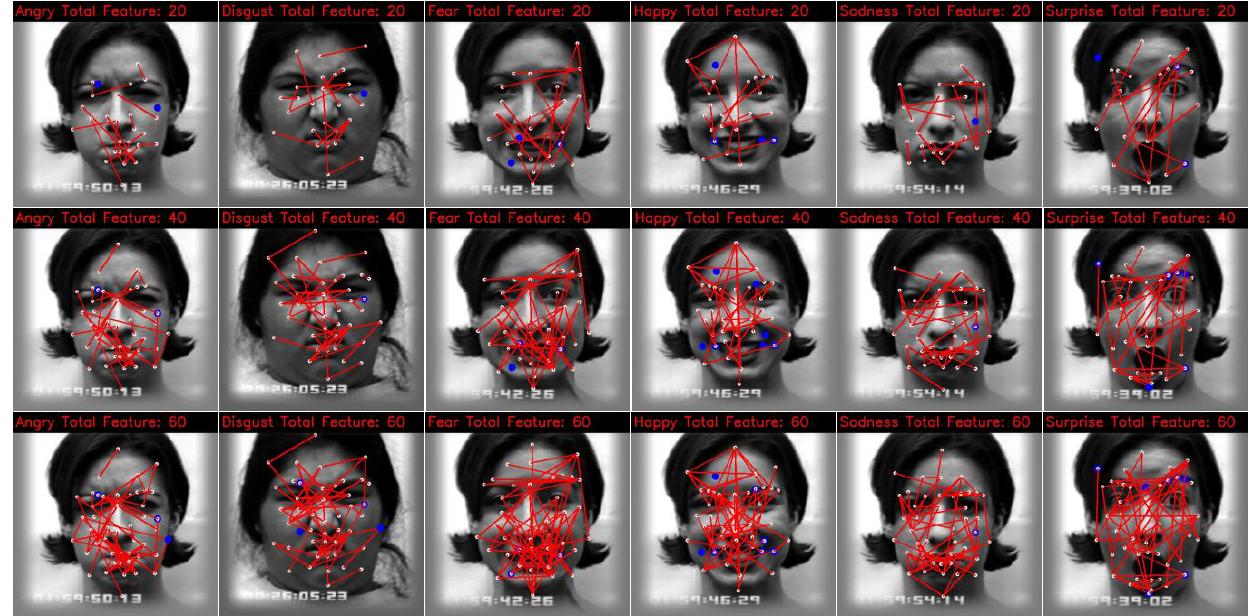
Figure 6. The first few (20, 40, and 60) features selected by AdaBoost for each class of facial expression. A red dot indicates a feature vector extracted from the tracking result of that landmark, as the facial expression evolves over time, whereas a red line connecting two landmarks indicates a feature vector extracted from the tracking result of those pair of landmarks, as the facial expression evolves over time.